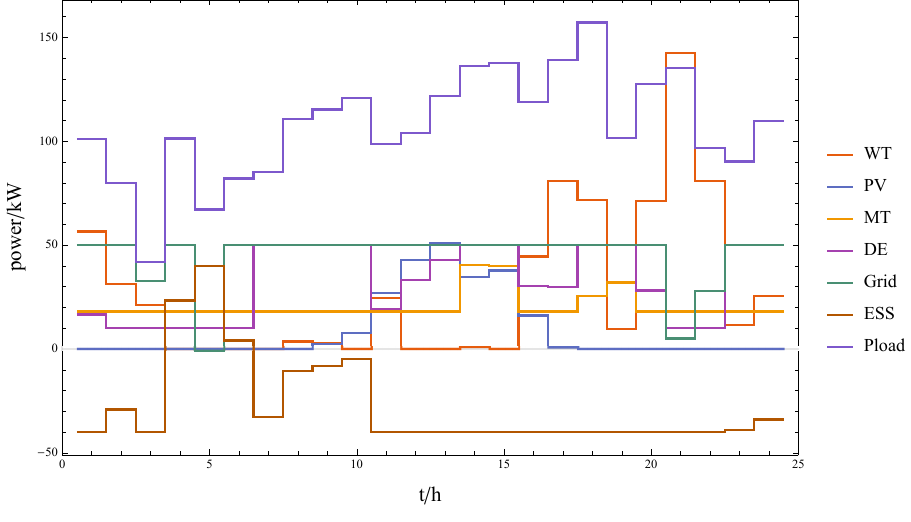
Figure 7. The output diagram of each part in the